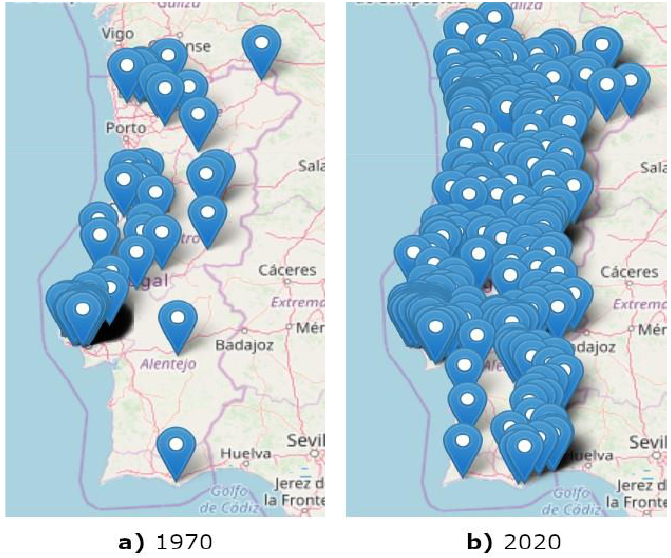
Figure 4. Maps with the locations, represented by blue dots, where R. grassei presence was reported until 1970 ( a )) and 2020 ( b )).